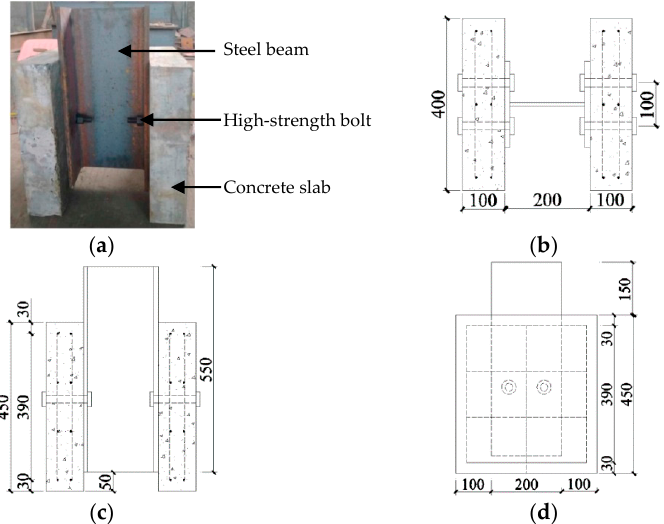
Figure 3. Details of push-off test specimens (Reprint with permission [19]; Copyright Year 2021, Publisher: Elsevier): ( a ) experimental specimens; ( b ) plan view; ( c ) front view; ( d ) side view.